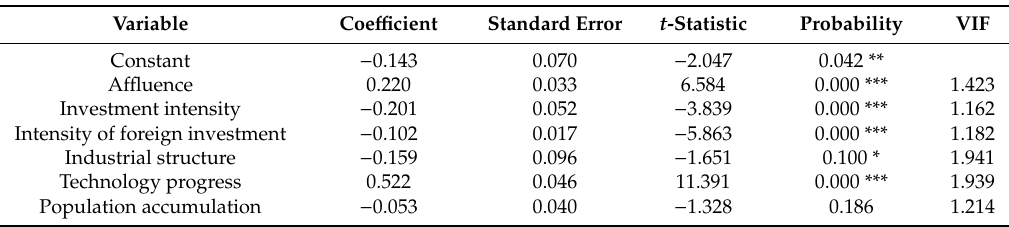
Table 3. Driving factors of urban eco-e ffi